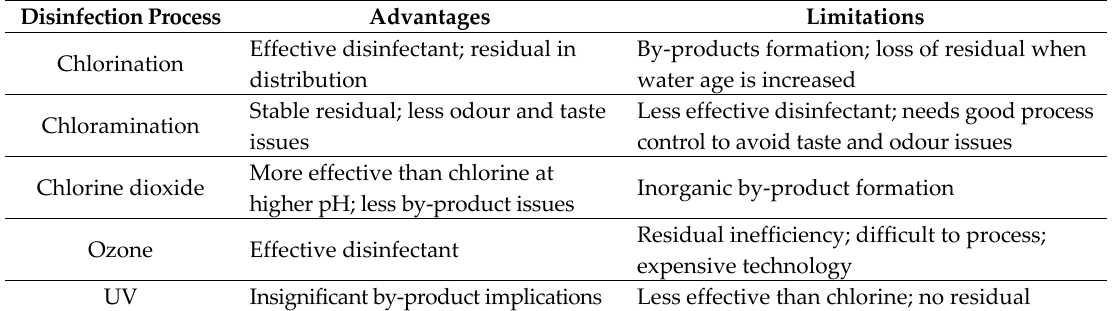
Table 1. Basic disinfection processes, their advantages and limitations (based on